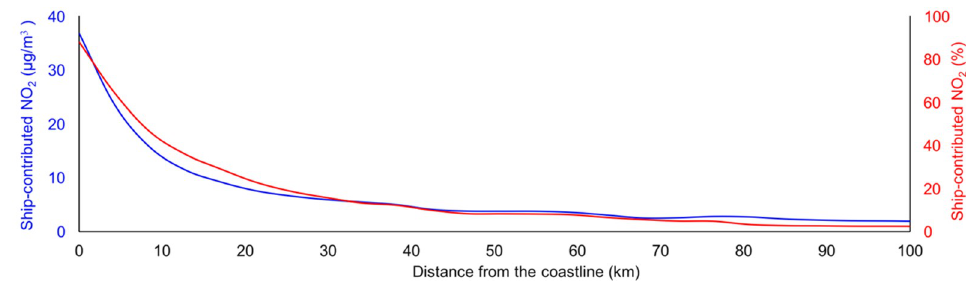
Figure 7. Variation of the averaged ship-contributed NO 2 in µ g / m 3 (blue curve) and in % (red curve) during the period from 12:00 to 24:00 at ground level with the distance from the coastline to inland along the black line depicted in Figure 6.